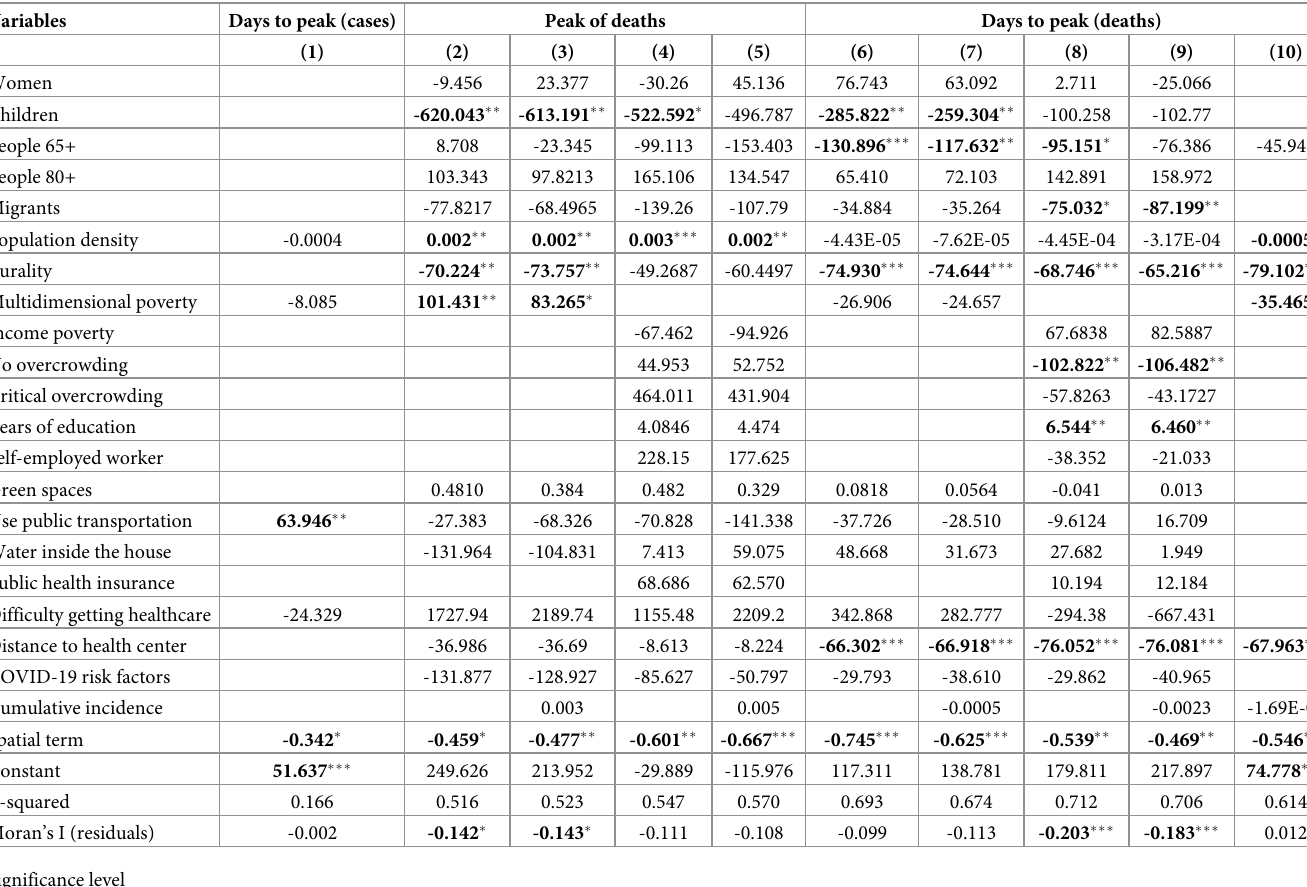
Table 7. Spatial